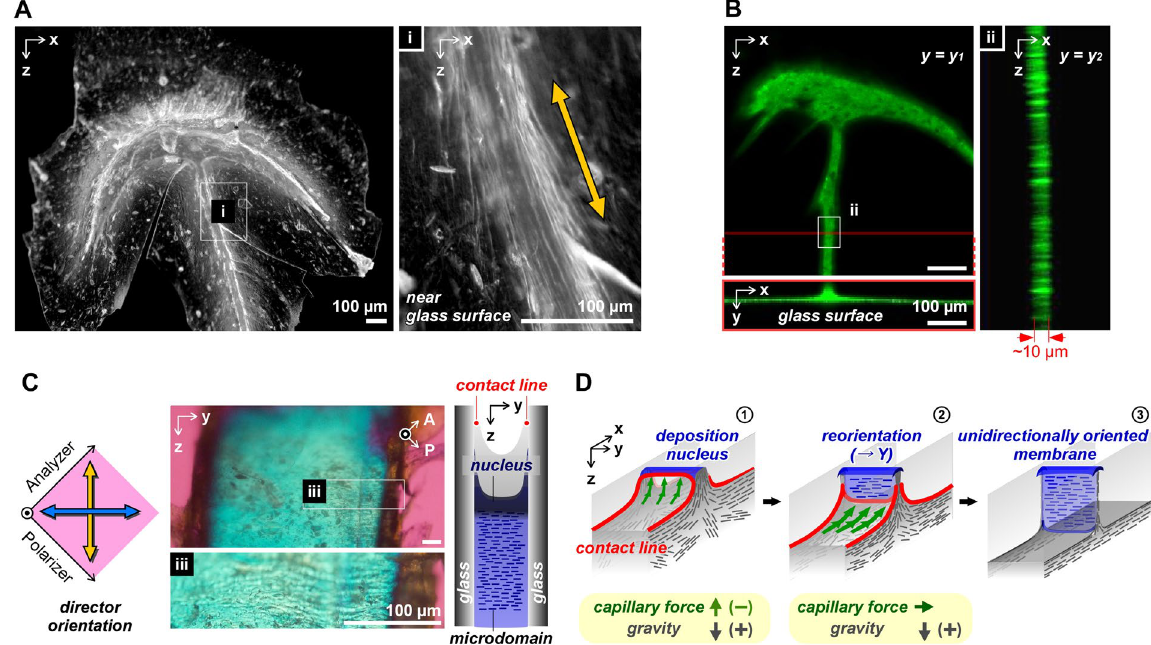
Figure 2. Microscopic images of a nucleus and the vertical membrane formed between glass slides. ( A ) Optical microscopic images of a dried membrane between glass slides observed from the XZ -plane. All scale bars = 100 µ m. ( B ) Confocal microscopic images of a dried membrane prepared from a FITC-conjugated sacran solution. All scale bars = 100 µ m. ( C ) Polarized microscopic images of the membrane in the YZ -plane observed through a retardation plate, λ = 530 nm and schematic illustration of the vertical membrane formed between the glass slides. All scale bars = 100 µ m. ( D ) Schematic illustration of a unidirectionally oriented membrane formation utilizing the air-liquid-solid phase contact line during the drying process in limited space. 1) Just after generation of nucleus, which links the glass slides, the capillary force on the nucleus is in the direction opposite that of gravity. 2) After formation of the nuclei-cap, the effect of the capillary force in the Z -direction is relieved. 3) The microdomain integrates with the contact line to form a unidirectionally oriented